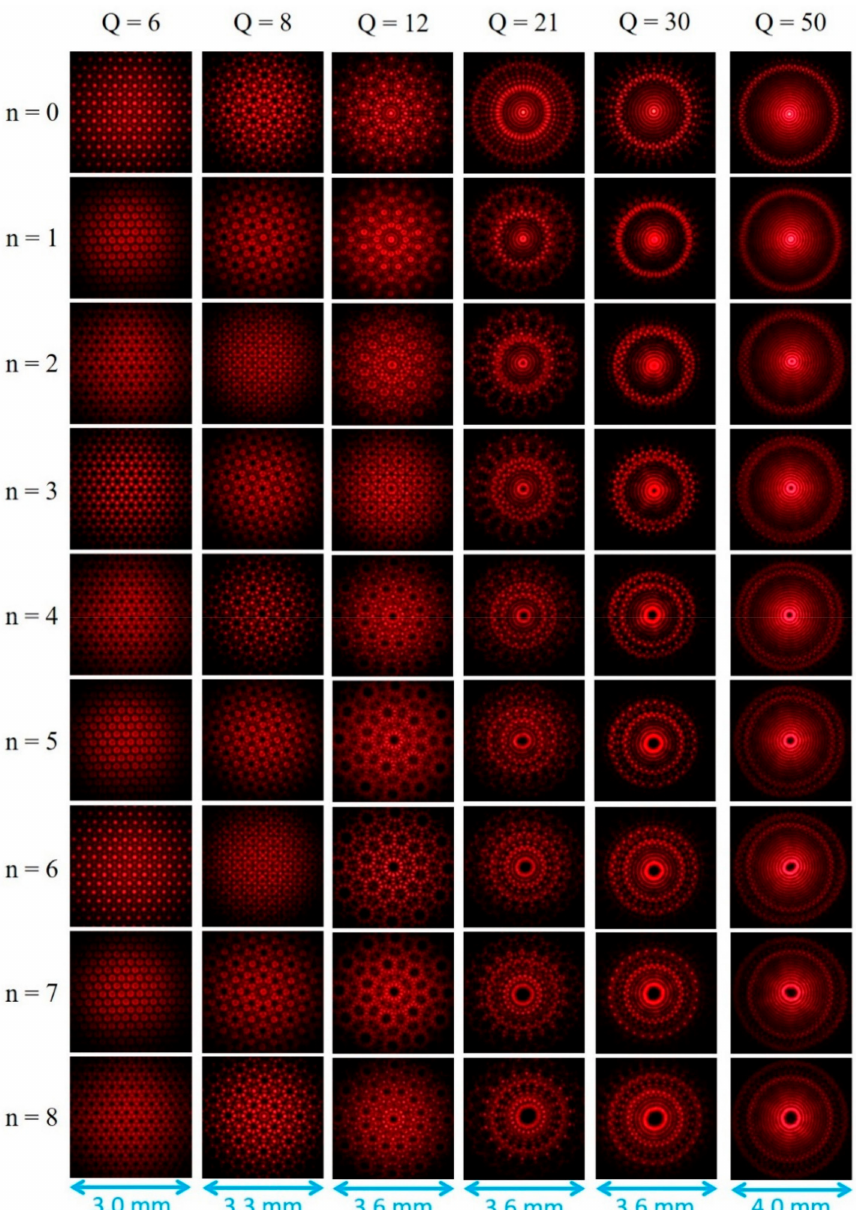
Figure 3. Experimental interference patterns that correspond one-to-one with the theoretical results shown in Figure